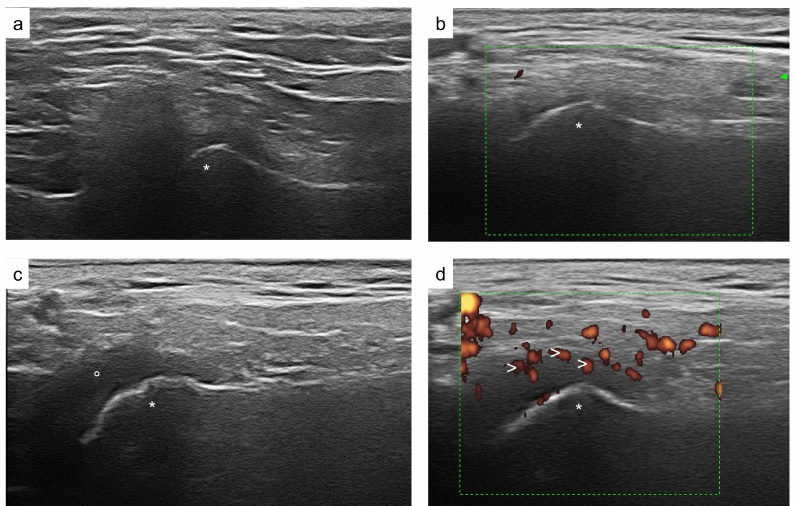
Figure 1. Ultrasound images of the temporomandibular joint. Regular TMJ aspect of grayscale and Power Doppler signal ( a , b ); abnormal TMJ findings: TMJ effusion ( c ); increased